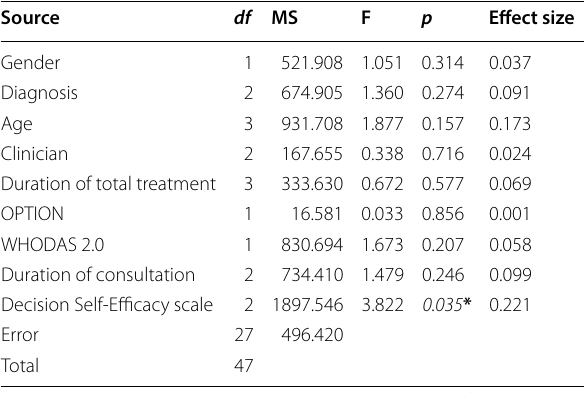
Statistically significant results are in italics, R 2 MS mean squares, effect size * Statistically significant at the 0.05